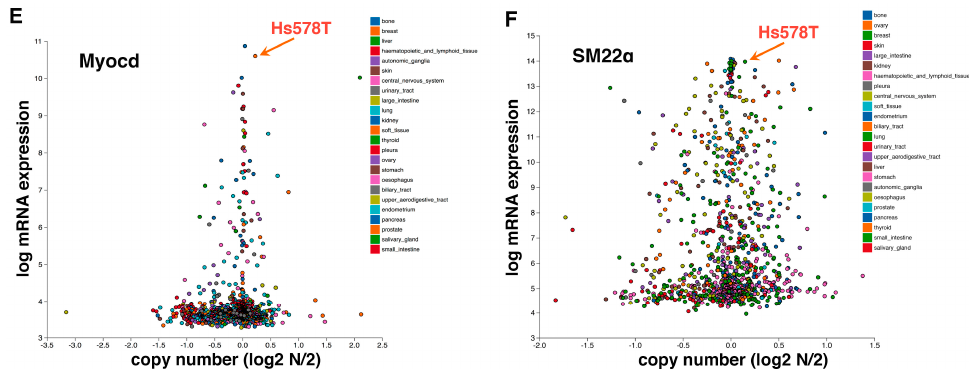
Figure 3. Hs578T triple-negative breast cancer cells, which behave like pericytes [12], express high levels of mesenchymal/mural cell markers N-cadherin ( A ), PDGFR β ( B ), NG2 ( C ), SMA ( D ), Myocardin (Myocd) ( E ), and SM22 α ( F ). Hs578T cells also highly express pericyte markers RGS5 and Angiopoietin 1 (Angpt.1) (data not shown). Gene expression is based on the Cancer Cell Line 1 (Angpt.1) (data not shown). Gene expression is based on the Cancer Cell Line Encyclopedia (CCLE) Encyclopedia (CCLE) database. Each dot represents an established human cancer cell line. database. Each dot represents an established human cancer cell